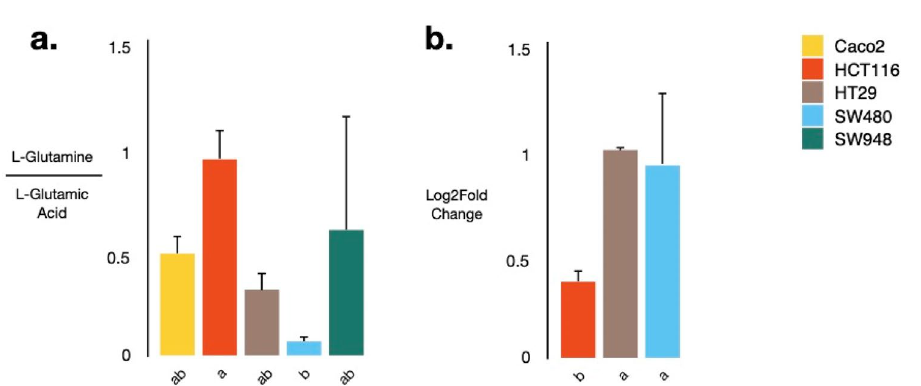
Figure 4. Conversion of L-glutamine to L-glutamic acid and expression of GLS1 in vitro. ( a ) Ratio L-glutamine/ glutamic acid was determined by using the individual metabolite abundances in the transformed cell line samples; ( b ) Expression of GLS1 , encoding glutaminase was assessed in the HCT116, HT29 and SW480 cell line by means of qPCR and expressed as log2 fold change relative to the HT29 cell line. Cell lines assigned with different letters are statistically ( P value < 0.05) different from each other. Error bars represent standard deviations (n =